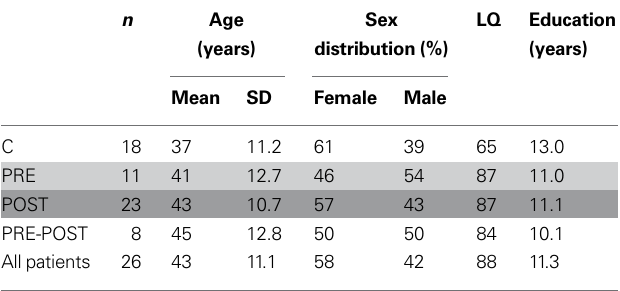
Table 1 | Characteristics of the different groups of